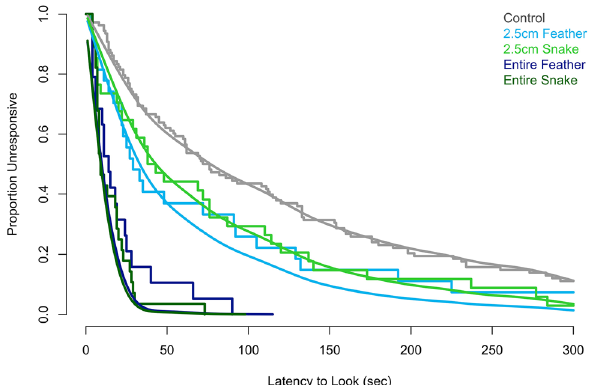
Figure 3. Empirical Kaplan–Meier survival/event time curves and model predictions for latency to look (s) for 40 titi monkeys in response to five stimulus types. Empirical curves were produced by the survfit function from the survival library 43 and are shown as stair-step lines, while model predictions are overlaid as smooth curves. Color denotes the stimulus